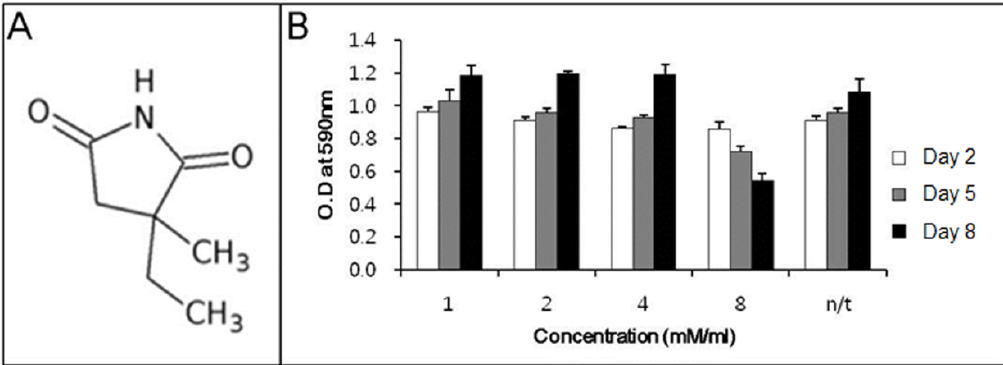
Figure 1. Structure of ethosuximide and cytotoxicity to rMDSCs. ( A ) The structure of ethosuximide, which is chemically designated as α -ethyl- α -methyl-succinimide (3-ethyl-3-methyl-pyrrolidine-2,5-dione; ( B ) Ethosuximide cytotoxicity was measured by the MTT assay. rMDSC neurogenesis was induced by treatment with 25 ng/mL bFGF for 24 h, and the medium was then replaced with medium containing the indicated concentrations of ethosuximide. MTT assays were performed after a total of 2, 5, or 8 days